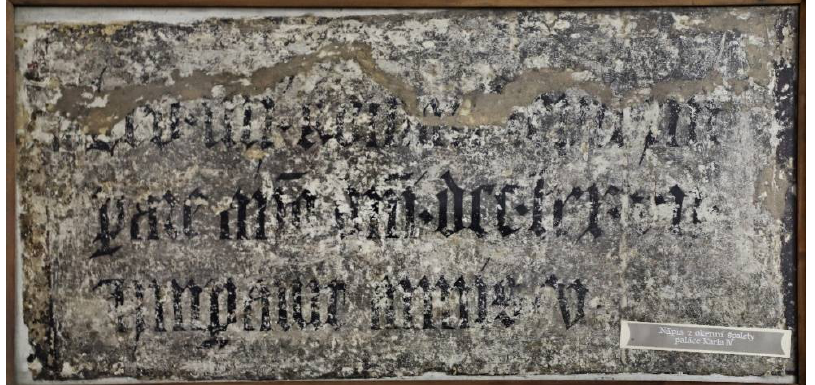
Figure 4. Prague Castle, transfer of the inscription from Vladislav Hall, today in the depository of Prague Castle. Photo by František Záruba, the author’s own work.